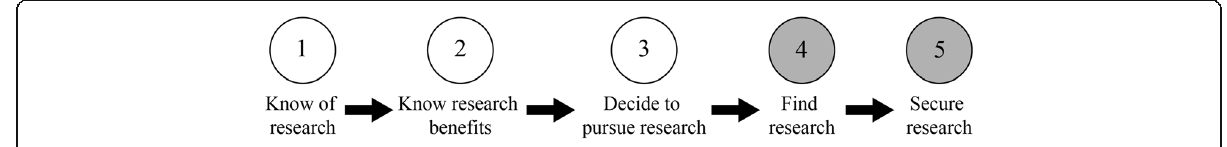
Fig. 3 Points along the process of obtaining an undergraduate research experience where we aimed to identify the rules of